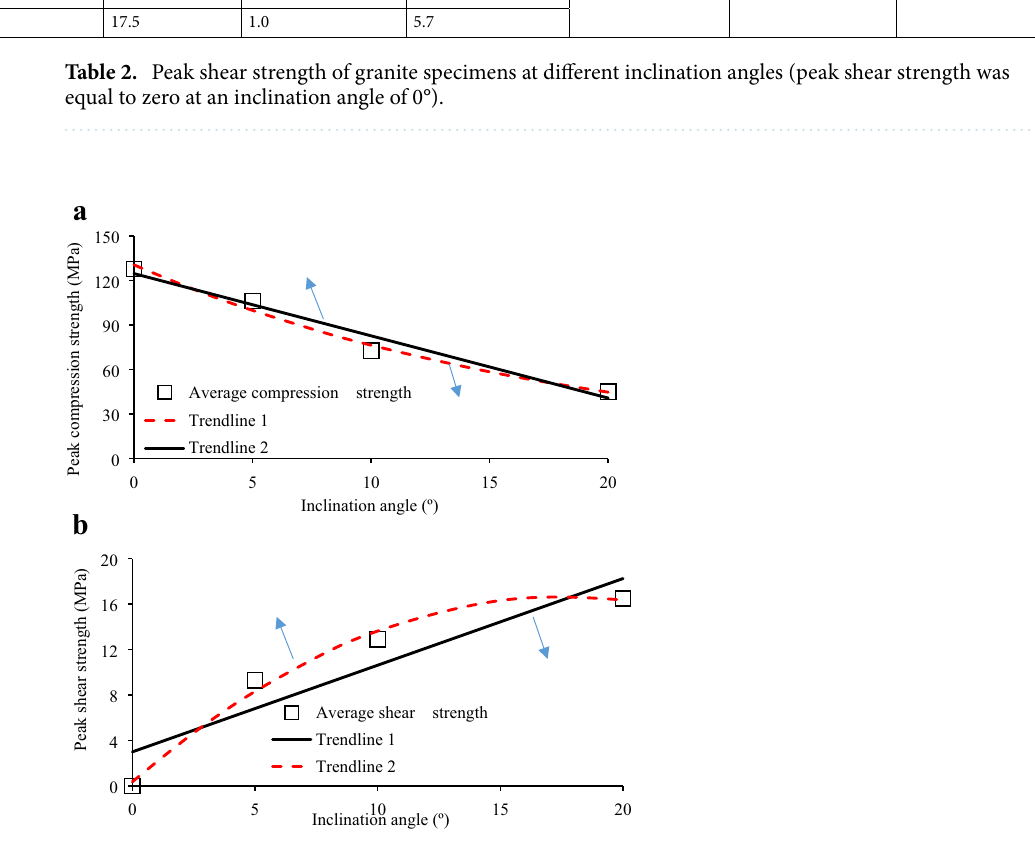
Figure 7. Specimen peak compression and peak shear strengths at different inclination angles. Trend lines 1 and 2 in Fig. 9a,b were fit against the data at an inclination angle range of 0° to